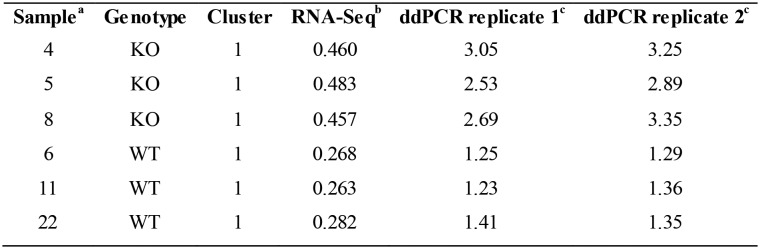
Dcpp expression confirmation.The relative expression levels of three Dcpp genes in cluster one samples. Comparison of RNA-Seq counts and two replicates of ddPCR experiments (see experimental details in the Materials and method section). Note that the three Dcpp genes (Dcpp1, Dcpp2, and Dcpp3) are too similar to each other to allow to place primers that could distinguish them. Hence, both the RNA-Seq counts, as well as the ddPCR results reflect the cumulative expression levels. ddPCR test on the relative expression levels of the three Dcpp genes in cluster one samples.